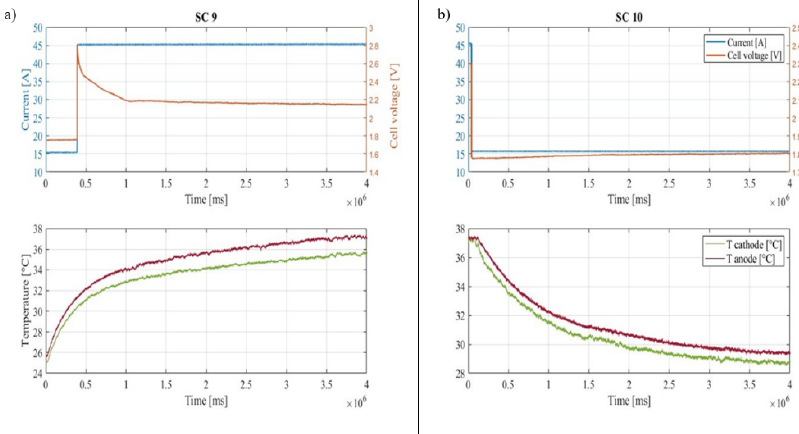
Figure 10. Obtained experimental results: ( a ) SC9 (15–45 A), and ( b ) SC10 (45–15 A).